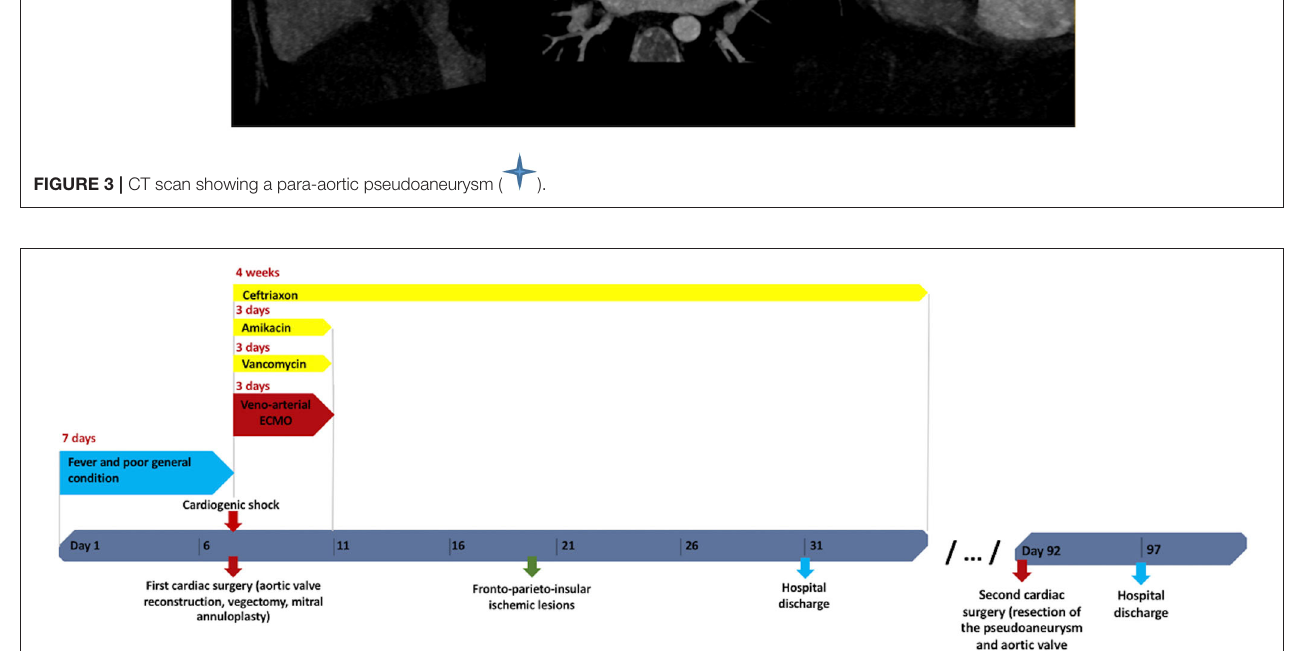
FIGURE 4 | Timeline of main events. ECMO, extracorporeal membrane